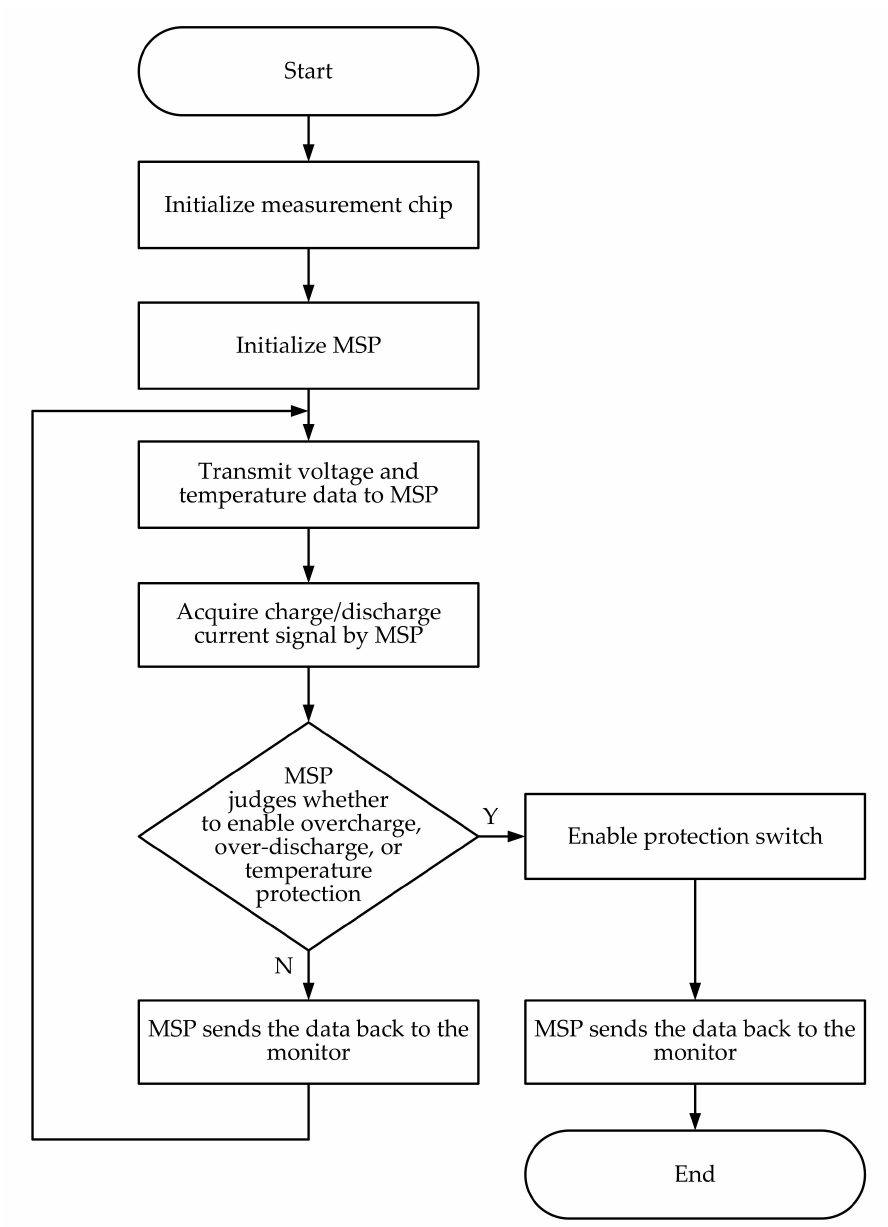
Figure 5. Overall flow chart of the management system